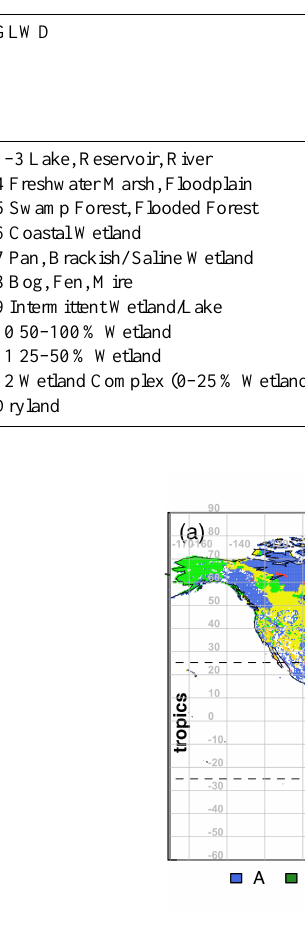
Figure 3. (a) Global distribution of important wetlands (by carbon mass) according to the Global Lakes and Wetlands Database and Global Land Cover Characterization. The most frequent wetland type is displayed within a 0.5 ◦ grid cell. Wetland types A–K are explained in Table 7. (b) Carbon mass in wetland soils (top 1m) in bands of 5 ◦ latitude (calculated from HWSD v.1.1-modified). (c) Carbon mass in aggregated types of wetland soils (b)